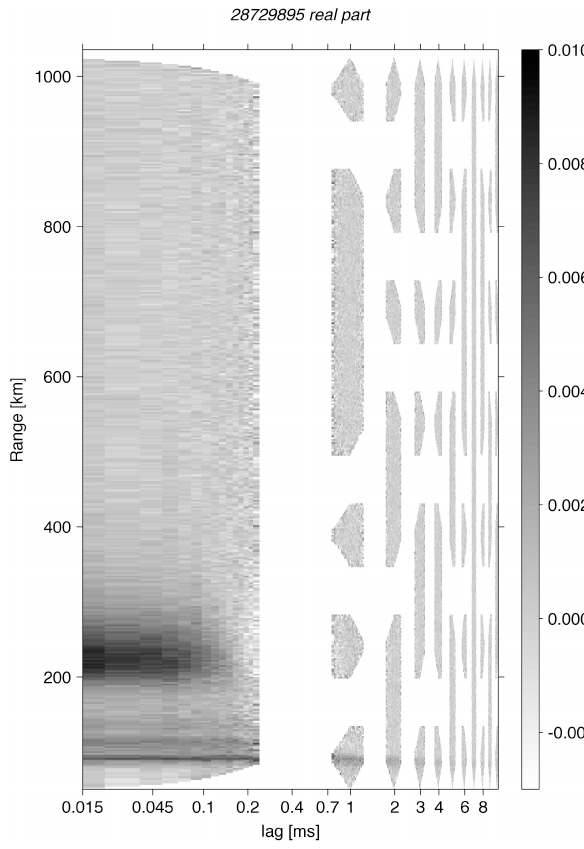
Fig. 7. The real part of the plasma scattering autocorrelation func- tion measured with the EISCAT Tromsø VHF radar on 28 Novem- ber 2008 (in arbitrary units). The ranges from 50 to 1000km are continuously covered with the short (15 to 225µs) lag profiles. In addition, several pulse-to-pulse lag profiles with a lag resolution of 990µs are measured. To underline the possibility of measuring the pulse-to-pulse correlations from all ranges, the E- and F-regions are also contained in the pulse-to-pulse part. Neither are nearby pulse- to-pulse lags integrated in the same profiles to demonstrate that the whole lag coverage presented in Fig. 2 is really possible to